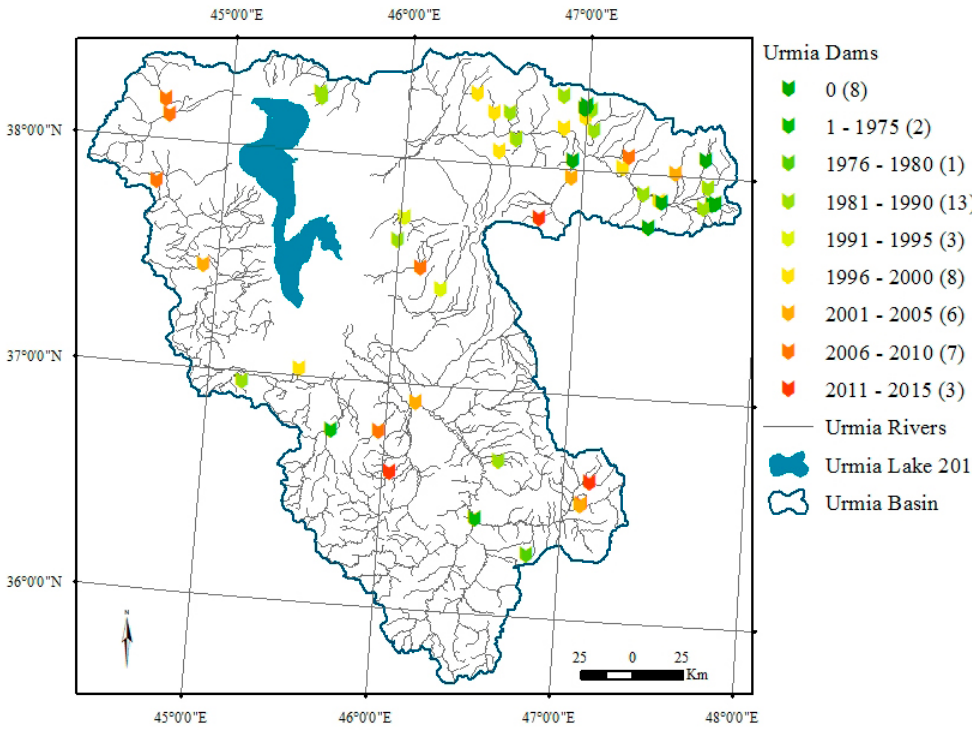
Figure 9. The geographical locations of dams (grouped by the year of operation) over Lake Urmia basin.